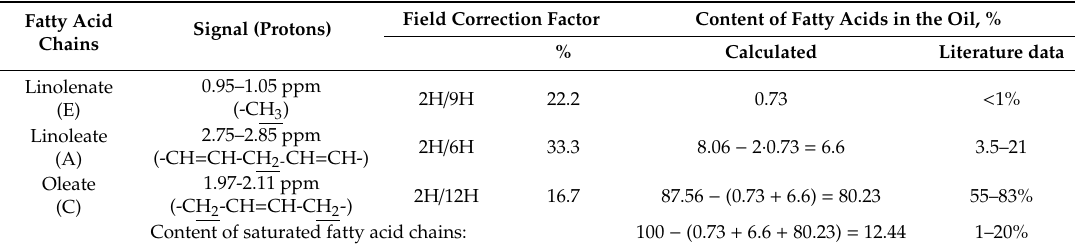
Table 1. Content of fatty acid chains in olive oil.